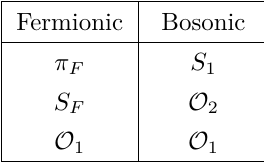
Table 1 . We find that shifting the spin-structure by a Z 2 flat connection has the effect of adding a bosonic SPT phase in the bosonized 2d theory. We see again that stacking with Arf and bosonizing produces theories related by